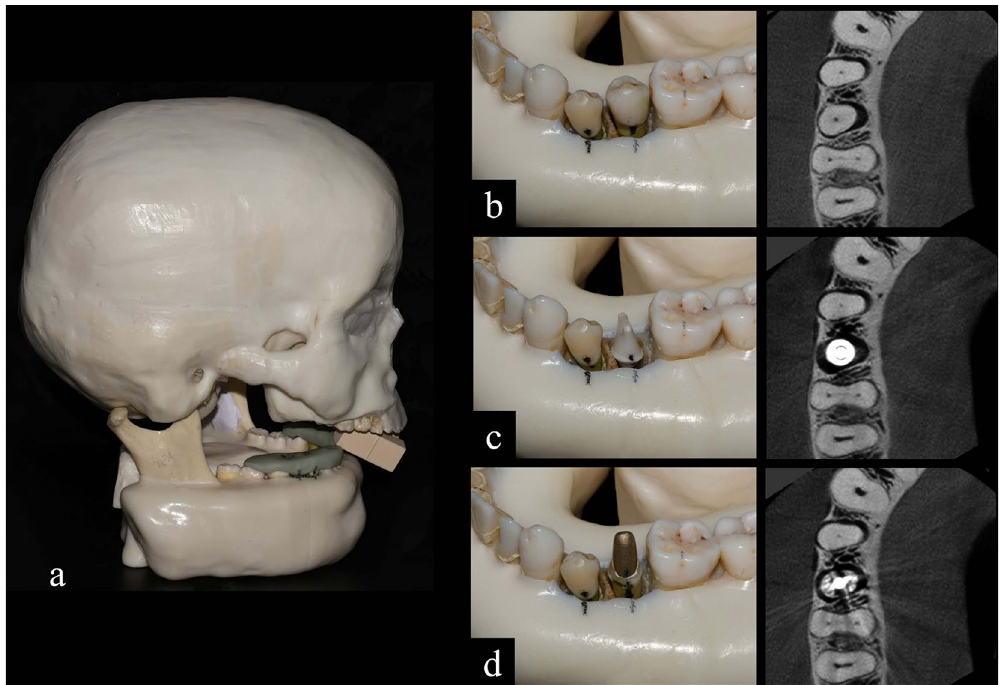
Figure 2. Anthropomorphic phantom of a dry human skull with mandible covered with mix-D ( a ) and representation of the region of interest considering the three conditions evaluated: metal-free ( b ), implant ( c ) and endo ( d ).